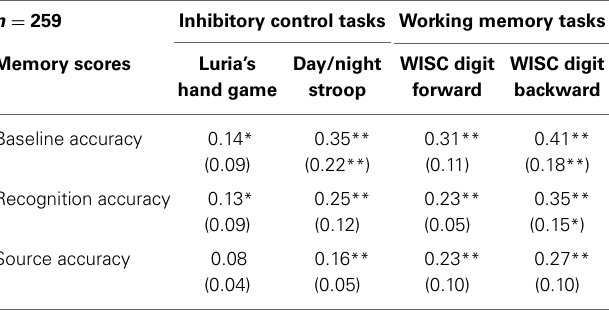
Table 4 | Correlations between memory scores and executive function